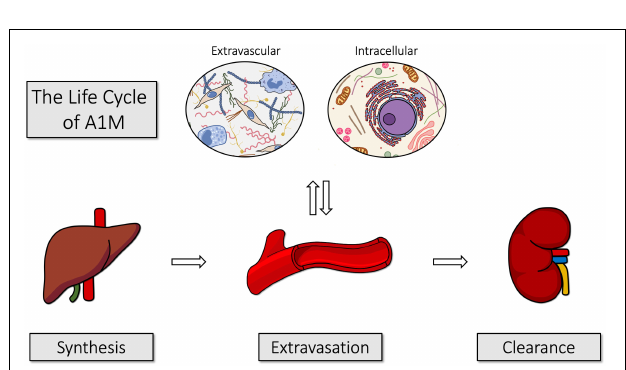
FIGURE 3 | The life cycle of A1M. A1M is primarily synthesized in the liver, from where it is secreted into the blood. It is rapidly equilibrated over the vessel walls of all organs and can be taken up intracellularly. After exerting its functions, it is transported to the kidneys and filtrated in the glomeruli. Finally, it is reabsorbed by the proximal tubular cells where it is degraded together with any bound heme groups and/or radicals.